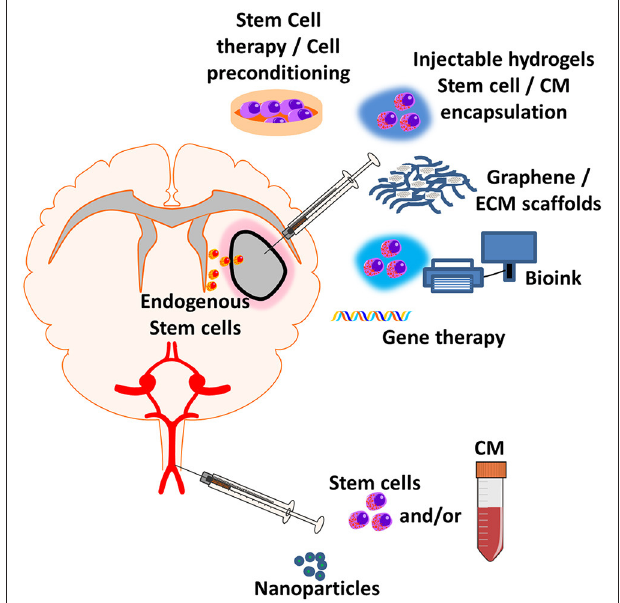
FIGURE 2 | Regenerative medicine applications for treating post-stroke inflammation. New emerging regenerative medicine approaches include central injection of cell therapy and/or encapsulated factor loaded hydrogels, graphene and ECM scaffolds, 3D-bioprinting of cell therapy and/or encapsulated factor loaded bioink, gene therapy which can be implanted directly into the site of injury. Systemic injection of nanoparticles with encapsulated anti-inflammatory factor, nanoparticles or cell therapy can either elicit an effect at the blood-brain barrier (BBB) or enter the parenchyma to elicit an effect at the site of injury. Exogenous administration of new regenerative medicine therapies could lead to the recruitment and infiltration of endogenous stem cells to stroke